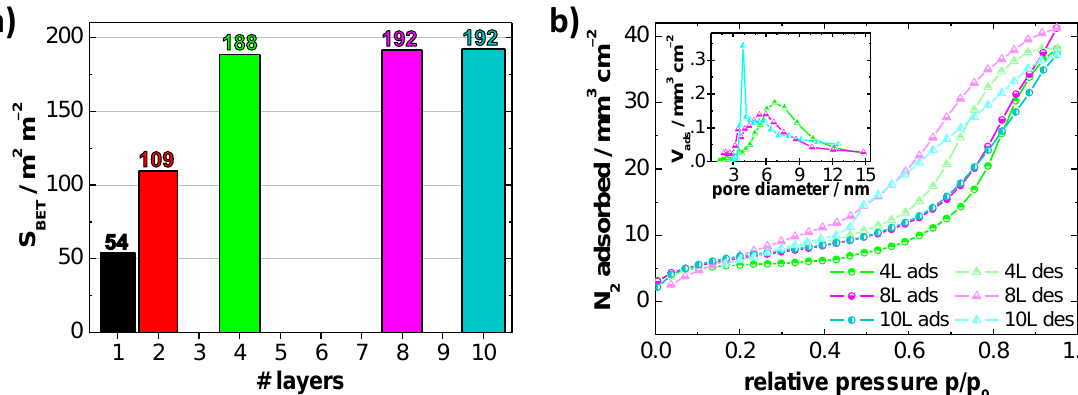
Figure 9. Nitrogen adsorption-desorption isotherms of multi-layered MTTFs calcined at 550 ◦ C. ( a ) The calculated BET surface areas as a function of the number of deposited MTTF layers and ( b ) nitrogen sorption isotherms and pore size distribution of selected